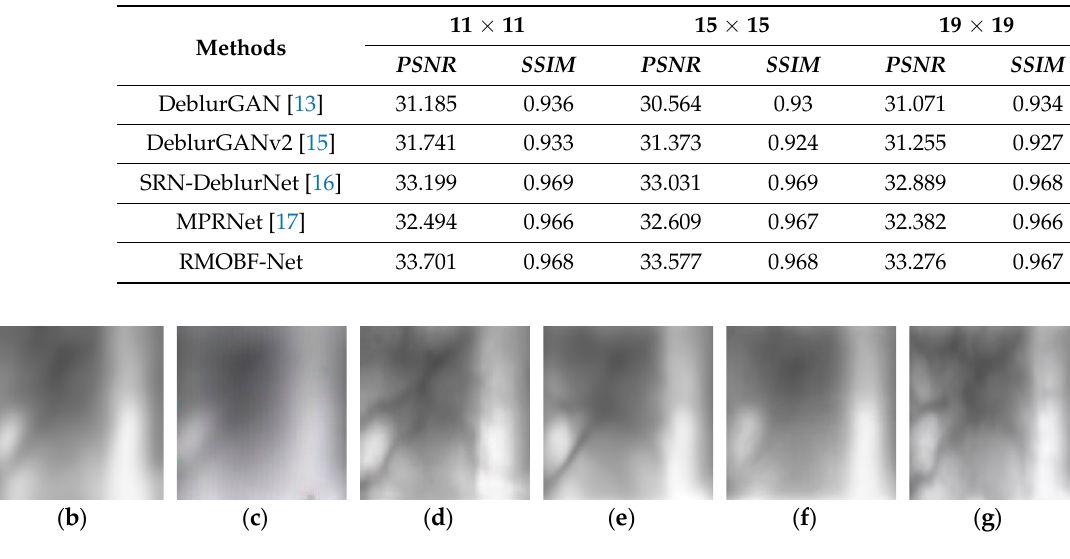
( g ) Figure 25. Examples of restored PolyU-DB finger-vein images using state-of-the-art methods and the proposed RMOBF-Net (motion blur with Gaussian blur filter of 15 × 15): ( a ) original image, ( b )